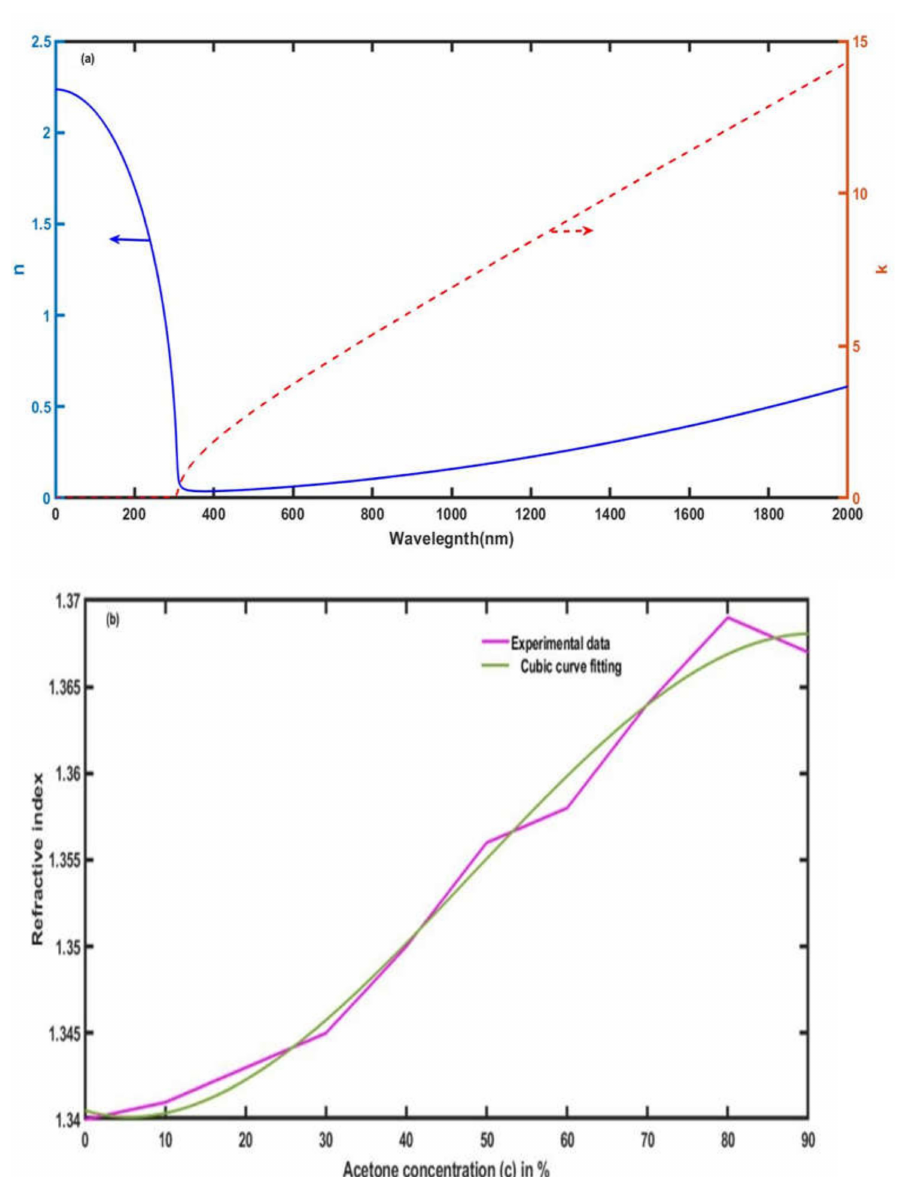
Figure 2. ( a ) The wavelength-dependent behavior of real ( n ) and imaginary ( k ) parts of the refractive index of silver ( n Ag ) and ( b ) The experimental and cubic curve fitting response showing the refractive index of water mixture ( n c ) dependent on acetone